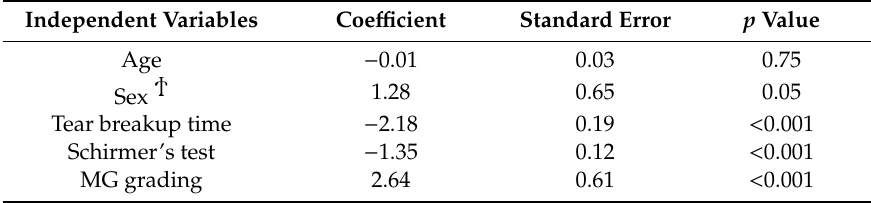
Table 2. Multiple regression with OSDI score as the dependent